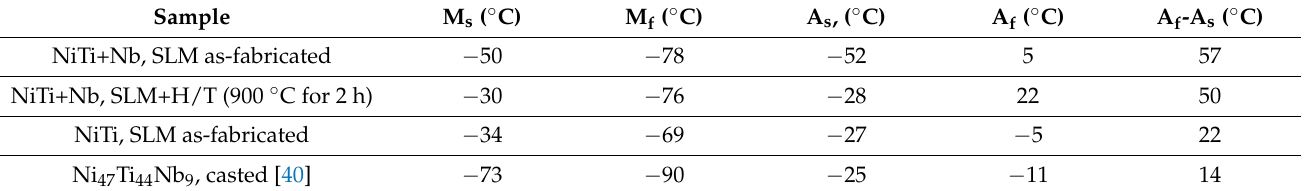
Figure 8. DSC-curves of the in-situ alloyed NiTiNb samples ( a ) in the as-fabricated state and ( b ) after annealing at 900 °C for 2 h. Table 3. Martensitic phase transformation temperatures of the fabricated alloys.